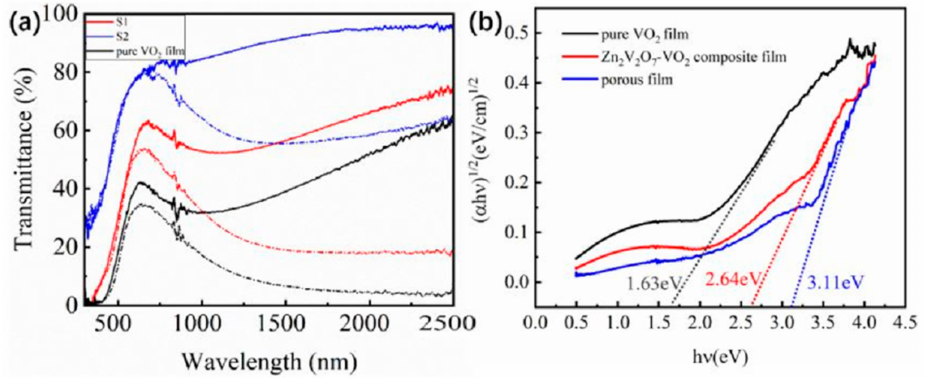
Figure 5. ( a ) the transmittance of sample S1, S2 and pure VO 2 film at 20 (line) and 90 ◦ C (short point line). ( b ) ( α h ν )1/2 and h ν plots for VO 2 , Zn 2 V 2 O 7 -VO 2 composite film, and porous film, indicating the optical band gap of each